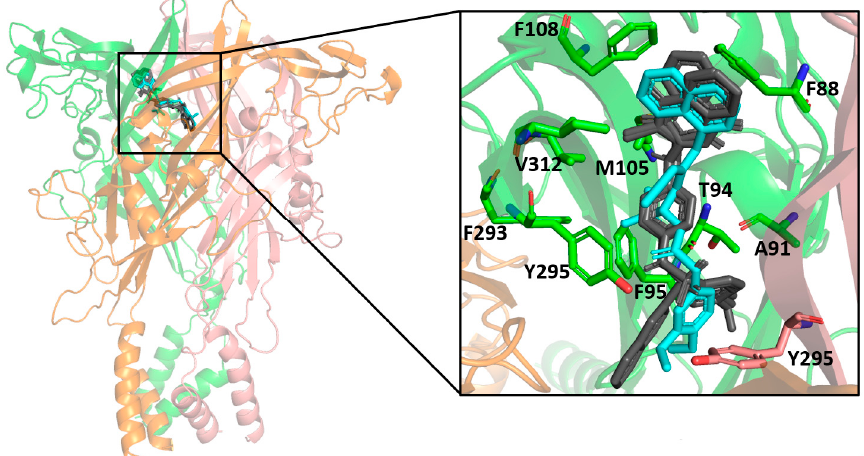
Figure 7. Superposition of the docked sulfonamide compounds into the P2X7 allosteric site. P2X7R is depicted in the cartoon, and each chain is represented in a different color. The sulfonamide ligands are depicted in gray, and the A740003 ligand is depicted in cyan. The main interacting residues are depicted in an enlarged view. The A740003 structure conformation was retrieved from PDB (ID: 5U1U).